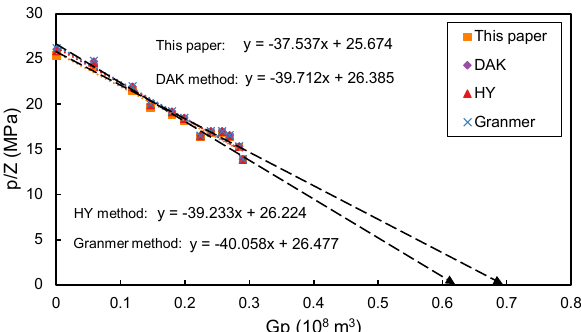
Figure 5. Example of dynamic reserves calculation using the material balance method, where the compressibility factors are computed from the four empirical